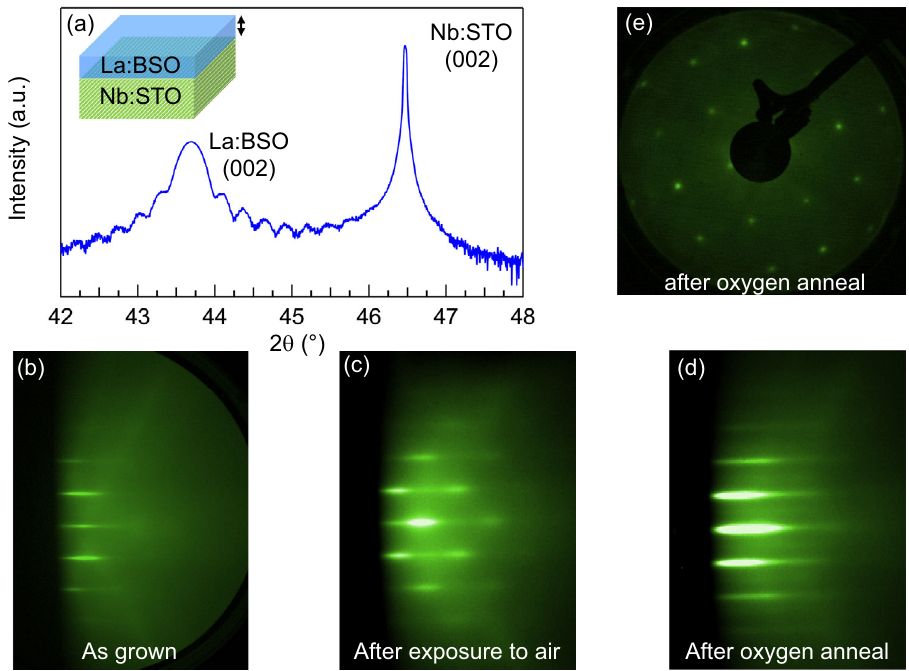
Fig. 1 X-ray diffraction, re fl ection high-energy electron diffraction (RHEED), and low-energy electron diffraction (LEED) of La-doped BaSnO 3 . a Angle X-ray diffraction of a 30-nm-thick La-doped BaSnO 3 fi lm grown on (001) oriented Nb-doped SrTiO 3 substrate. RHEED pattern taken along the [100] azimuth after ( b ) growth (in situ at 14 keV), c ex situ transfer and exposure to air, and d high-temperature oxygen annealing to remove surface contamination. e LEED pattern at 147 eV, acquired from the surface after oxygen